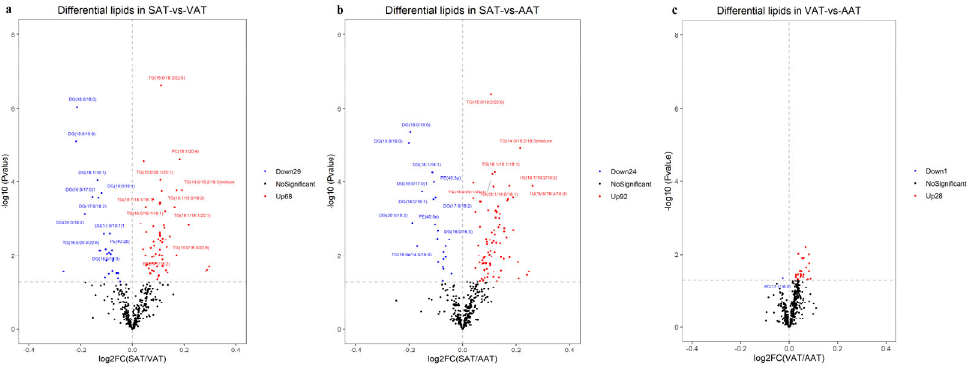
Figure 9. Volcano plots of differently accumulated lipids in SAT − VAT ( a ), SAT − AAT ( b ), and VAT − AAT ( c ) comparative groups.